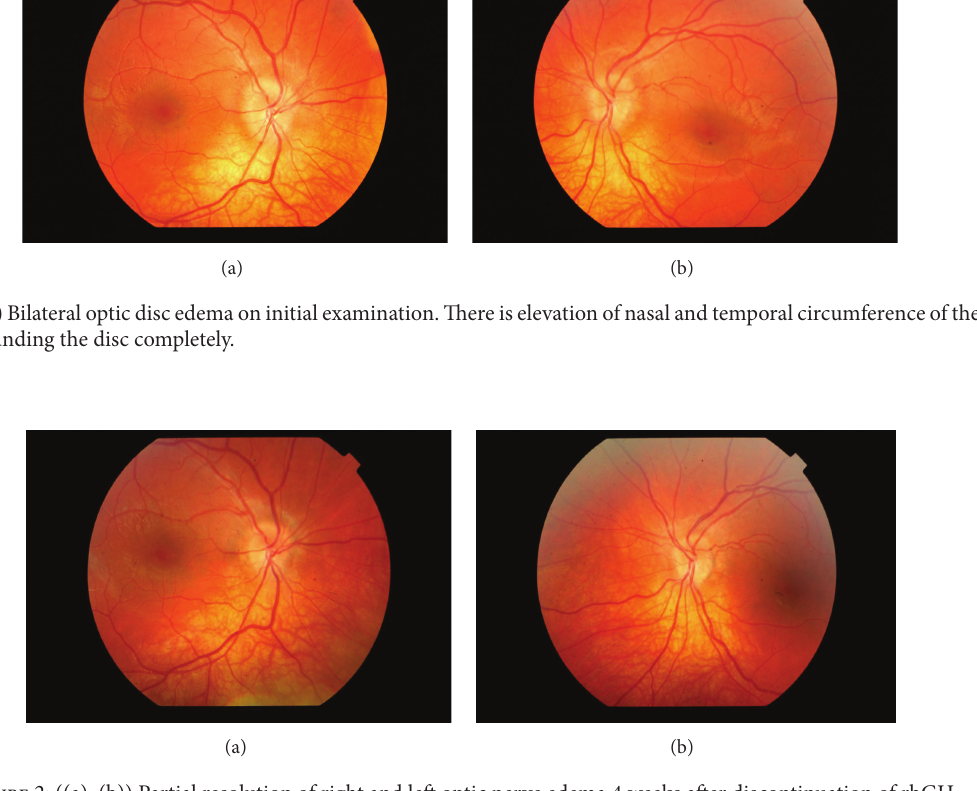
Figure 2: ((a), (b)) Partial resolution of right and left optic nerve edema 4 weeks after discontinuation of